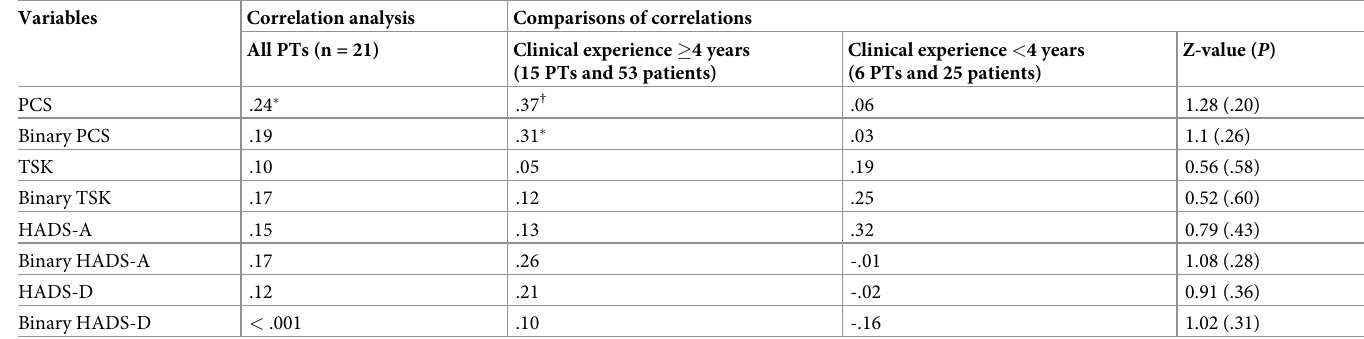
Table 2. Correlations (Spearman’s ρ ) among total and binary scores of psychological patient-reported outcome measure scores and physical therapist (PT) numeri- cal rating scales in all PTs and comparisons of correlations between the two subgroups of PTs according to clinical